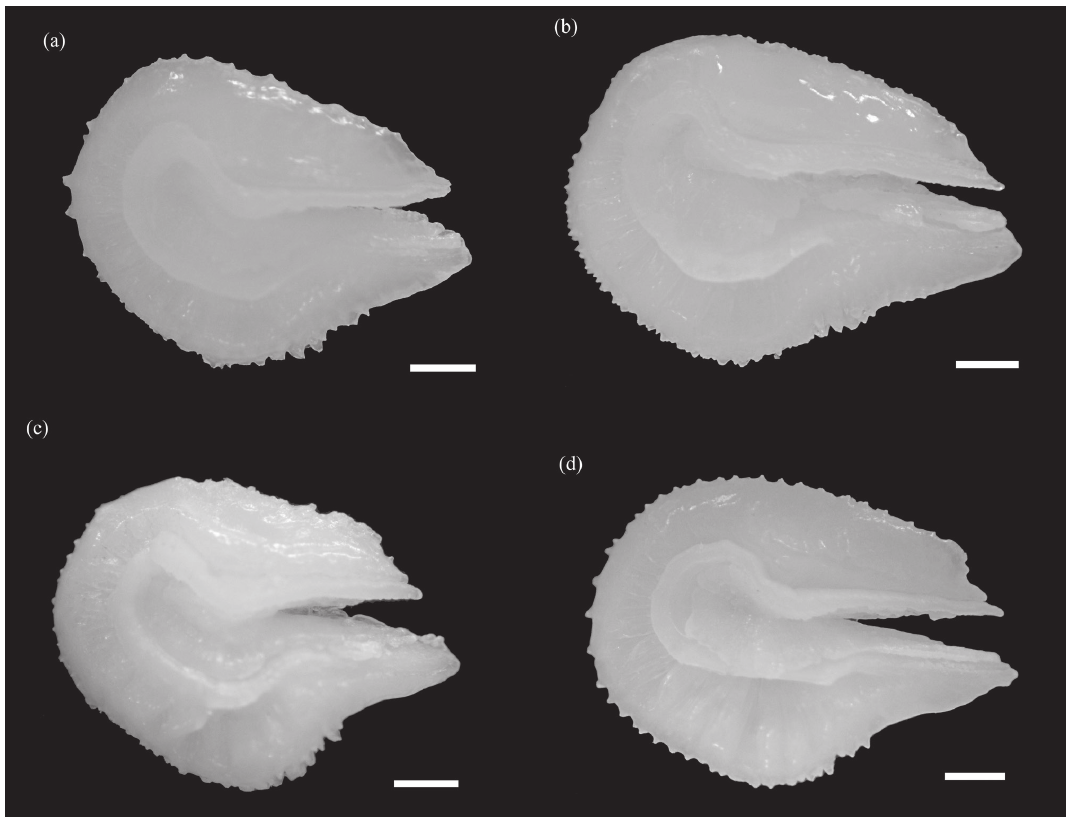
Fig. 4. Four morphotype asteriscus otolith Prochilodus nigricans established by cluster analysis from the amplitudes of wa- velets. a. morphotype 1; b. morphotype 2; c. morphotype 3 and d. morphotype 4 respectively, sampled of rivers Solimões, Japurá and Negro. Scale bars: 1